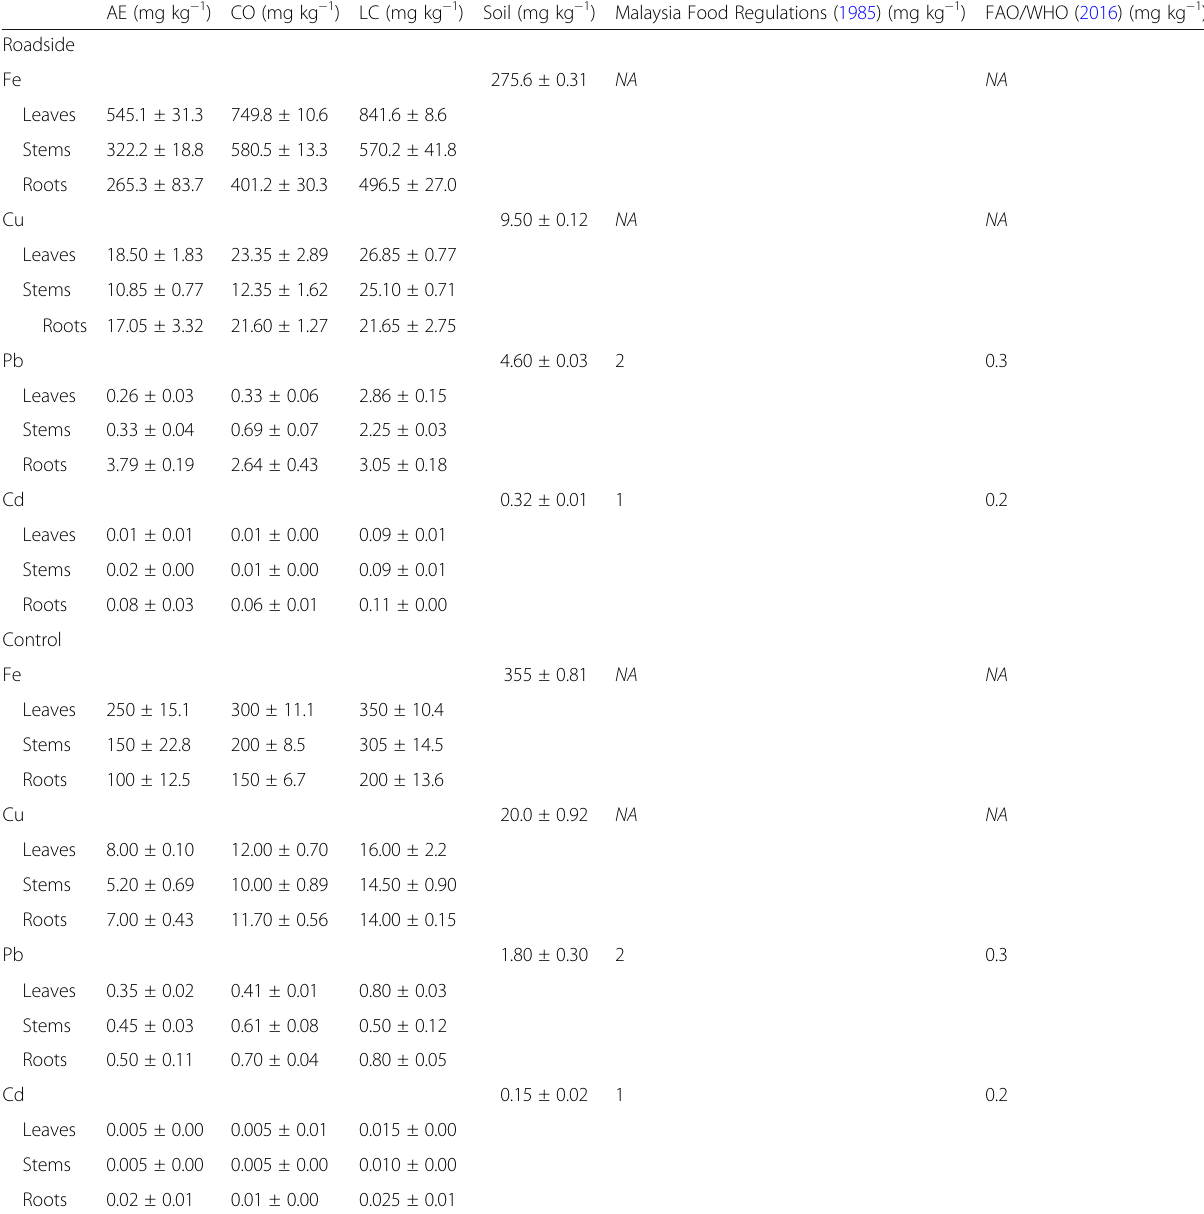
Table 1 Heavy metal concentrations (mean ± standard deviation) in Athyrium esculentum (AE), Chromolaena odorata (CO), Lantana camara (LC), and soils for roadside plants and